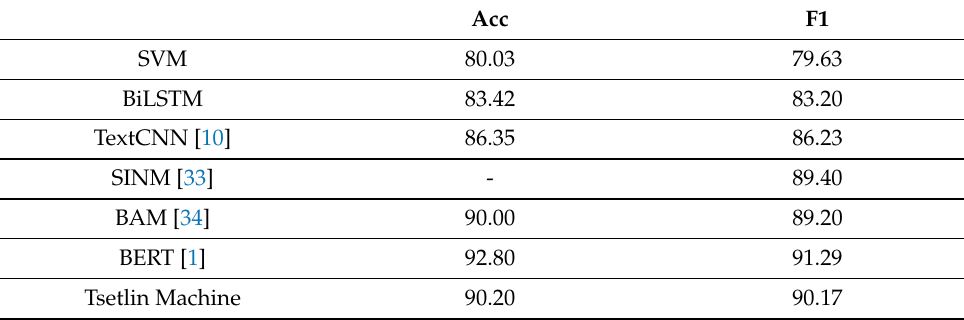
Table 3. Experimental Result in